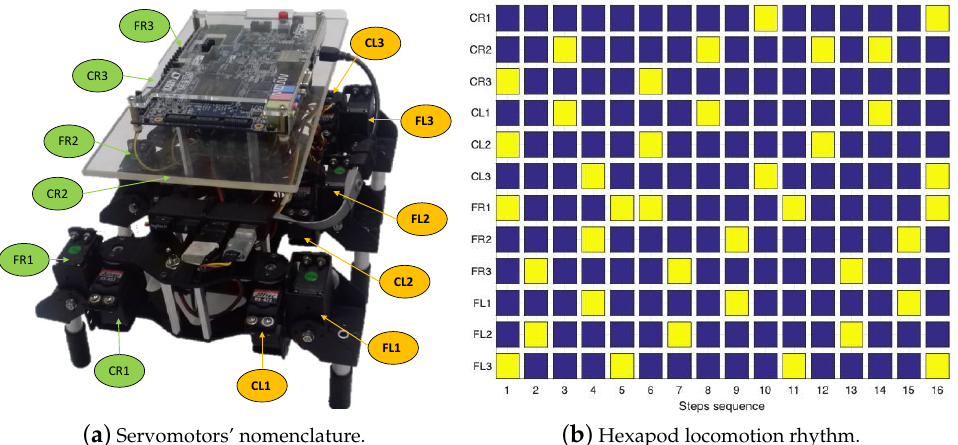
Figure 9. ( a ) The SoCKit-hexapod embedded system. The hexapod operates with twelve degrees of freedom using the Coxa (C) and Femur (F) articulations on the Right (R) and Left (L) sides. ( b ) Hexapod locomotion patterns. At any locomotion step, the corresponding servomotor activation is painted in yellow and deactivated in